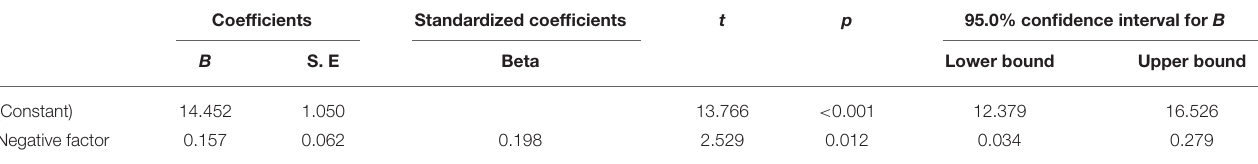
TABLE 4 | Predictors generated by Multivariate Logistic Regression with ASEX total score as dependent